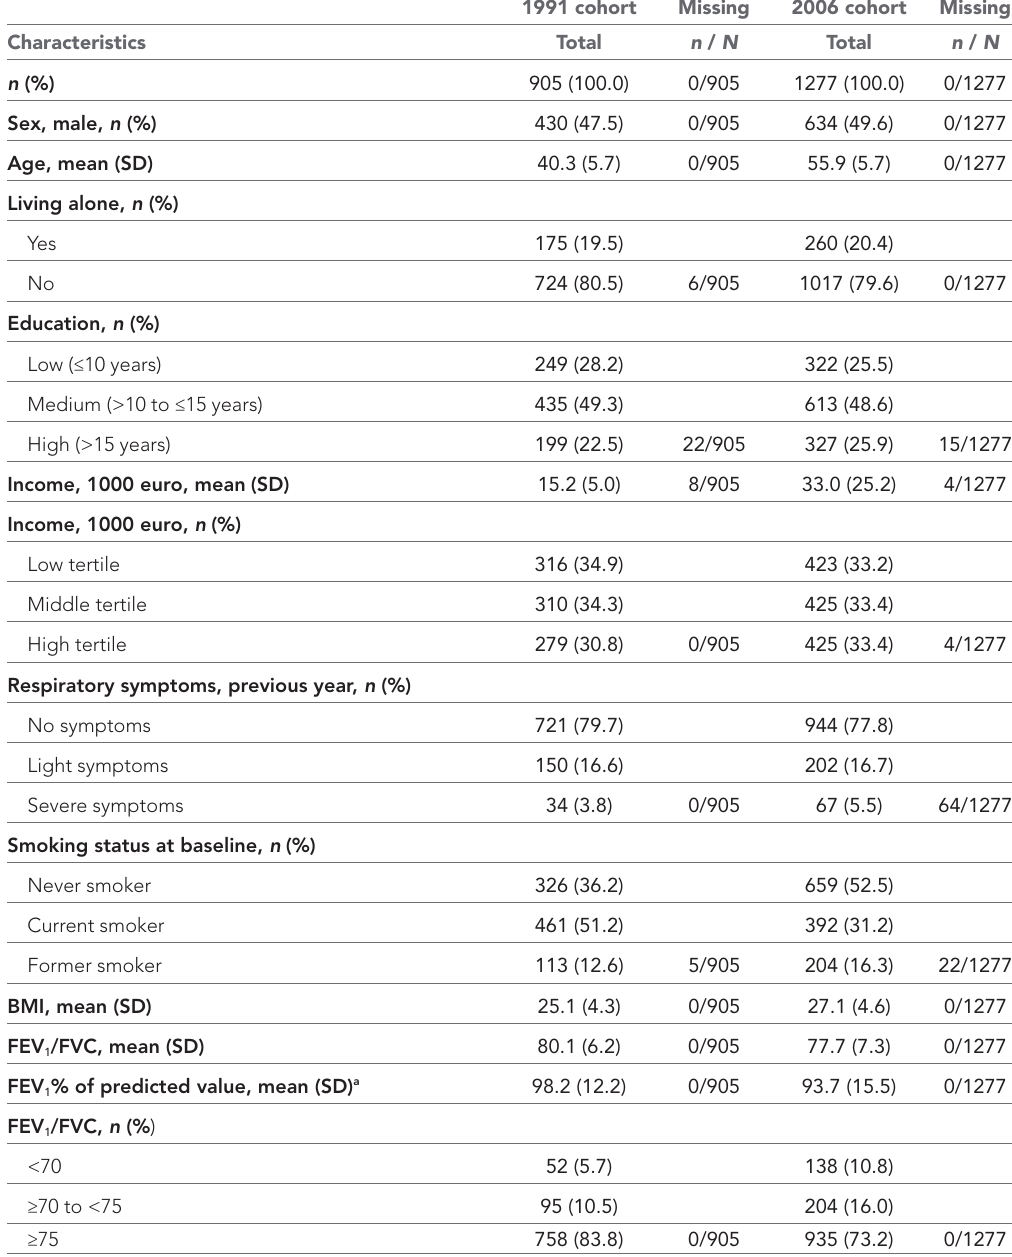
Table 1 Baseline characteristics of the 1991 cohort and the 2006